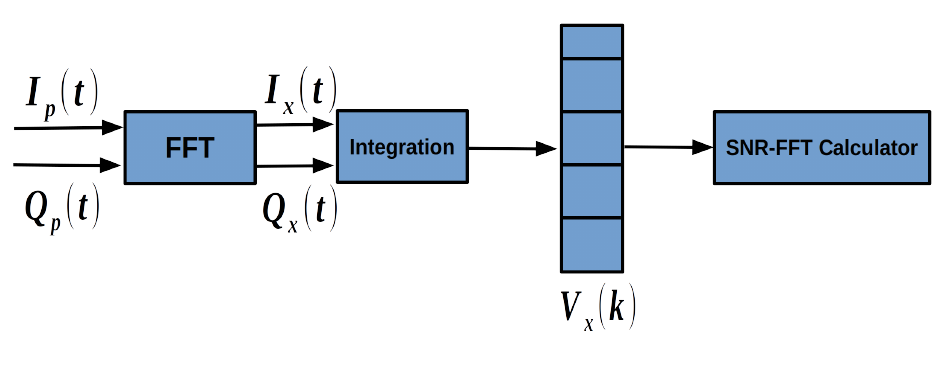
Figure 4. FFT-SNR